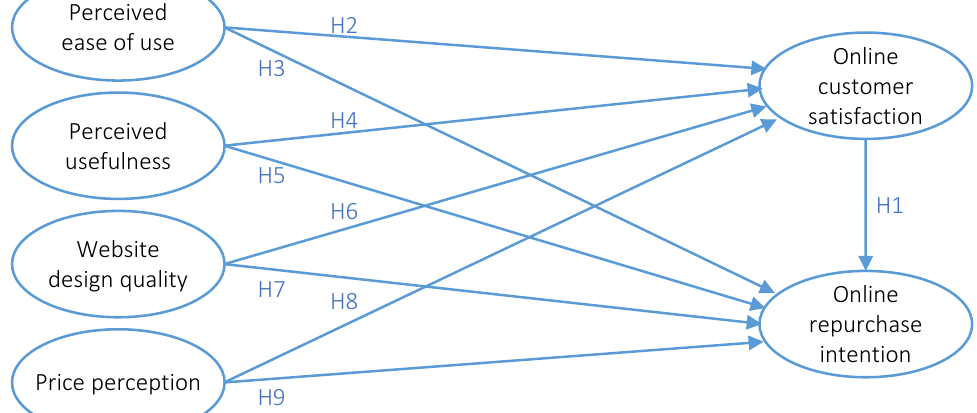
Figure 1. Research